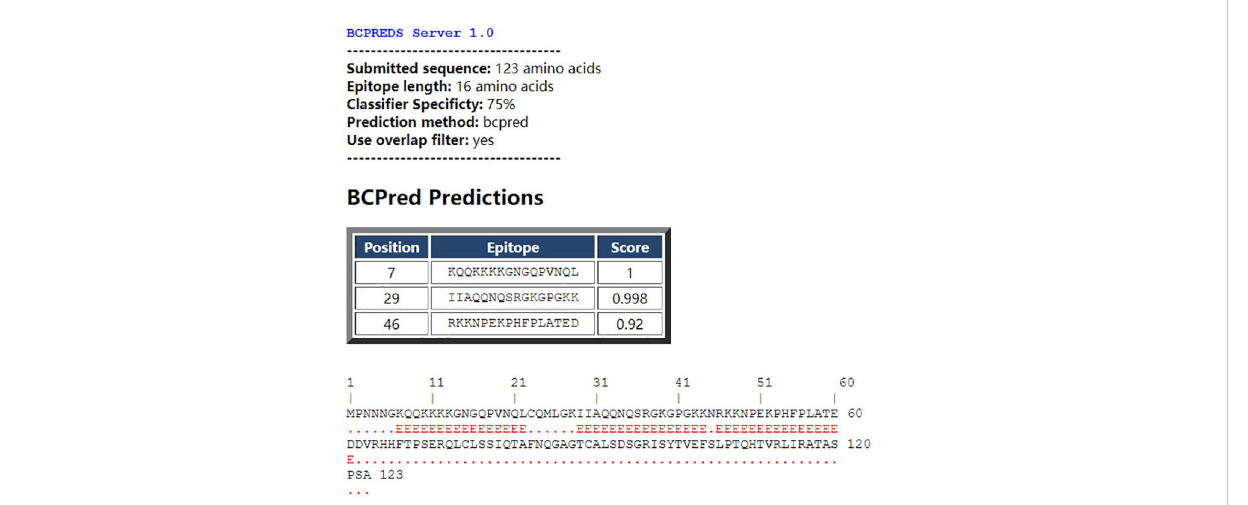
FIGURE 4 B-cell epitope prediction using the B-cell epitope prediction (BCPred) server. The porcine reproductive and respiratory syndrome virus (PRRSV) N protein amino acid sequence was applied to the BCPred method at a length of 16 amino acids and three peptides. A score of > 0.9 was